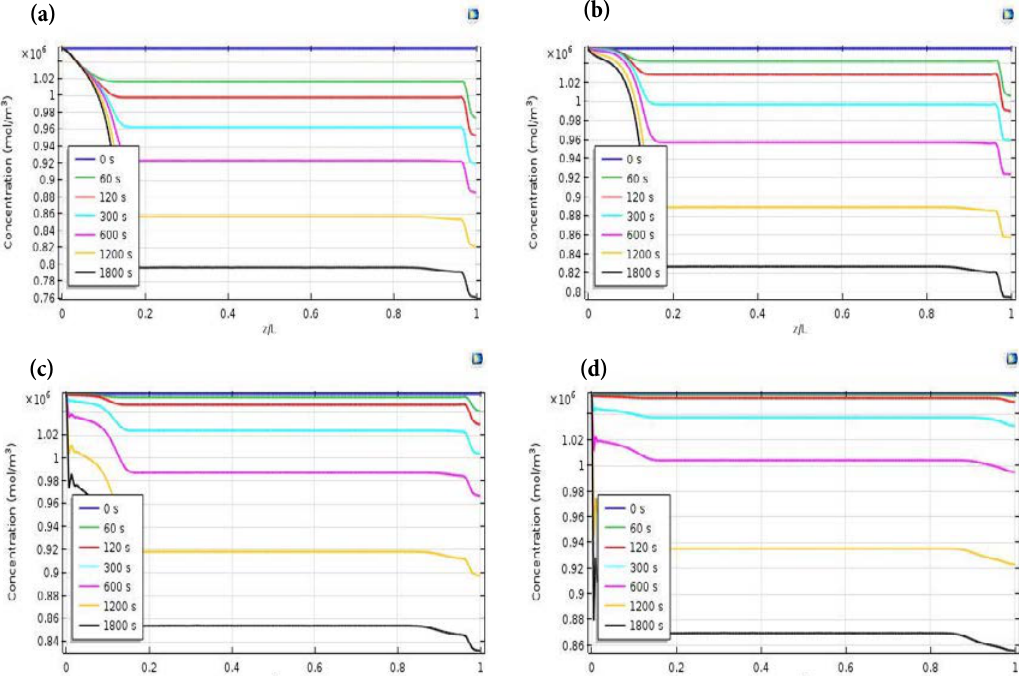
Fig. 10: Water concentration distribution in feed phase vs. dimensionless length (0.5 l/min feed flow rate and 30°C temperature) at various radii; (a) r=7.1 mm, (b) r=7.5 mm, (c) r=8 mm and (d) r=8.5